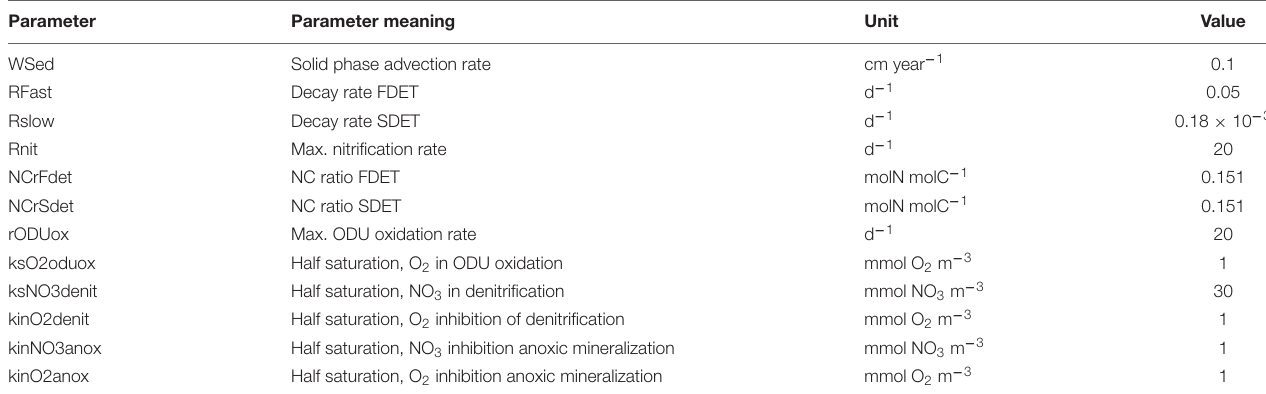
TABLE 2 | Definition of the parameters and values of fixed